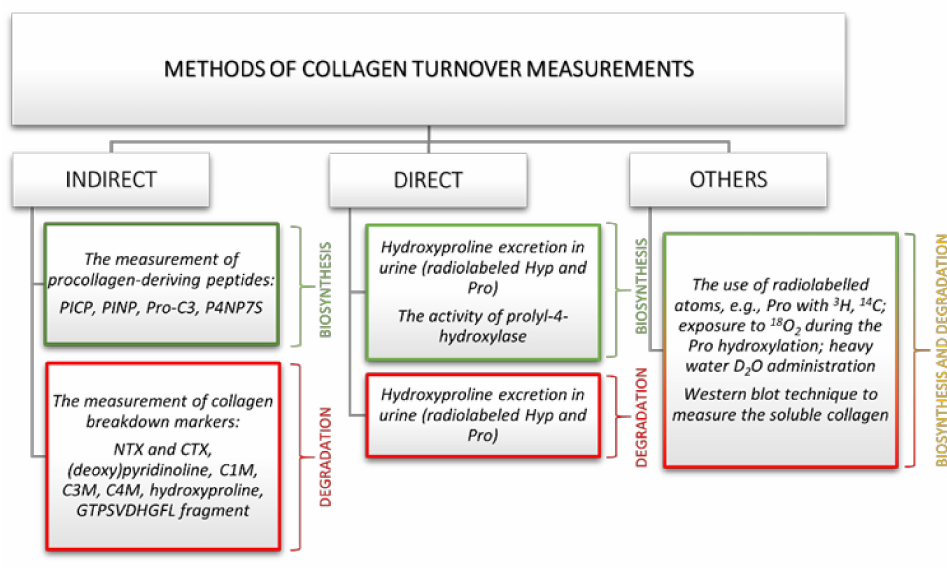
Scheme 2. Methods of collagen turnover measurements discussed in this review. All abbreviations are explained in the text